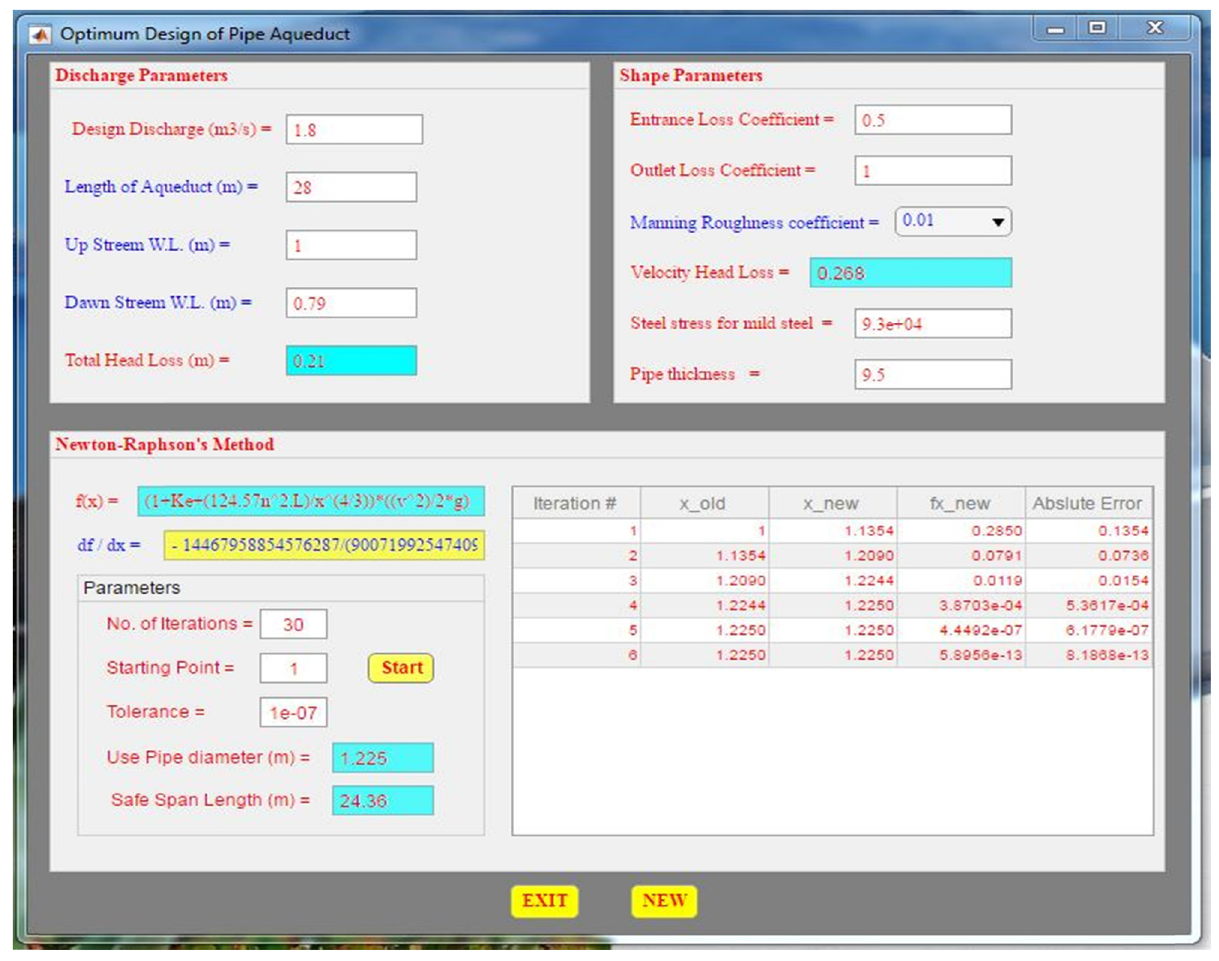
Figure 2: Shows the MATLAB application we developed to determine the best hydraulic design for the pipe aqueduct.